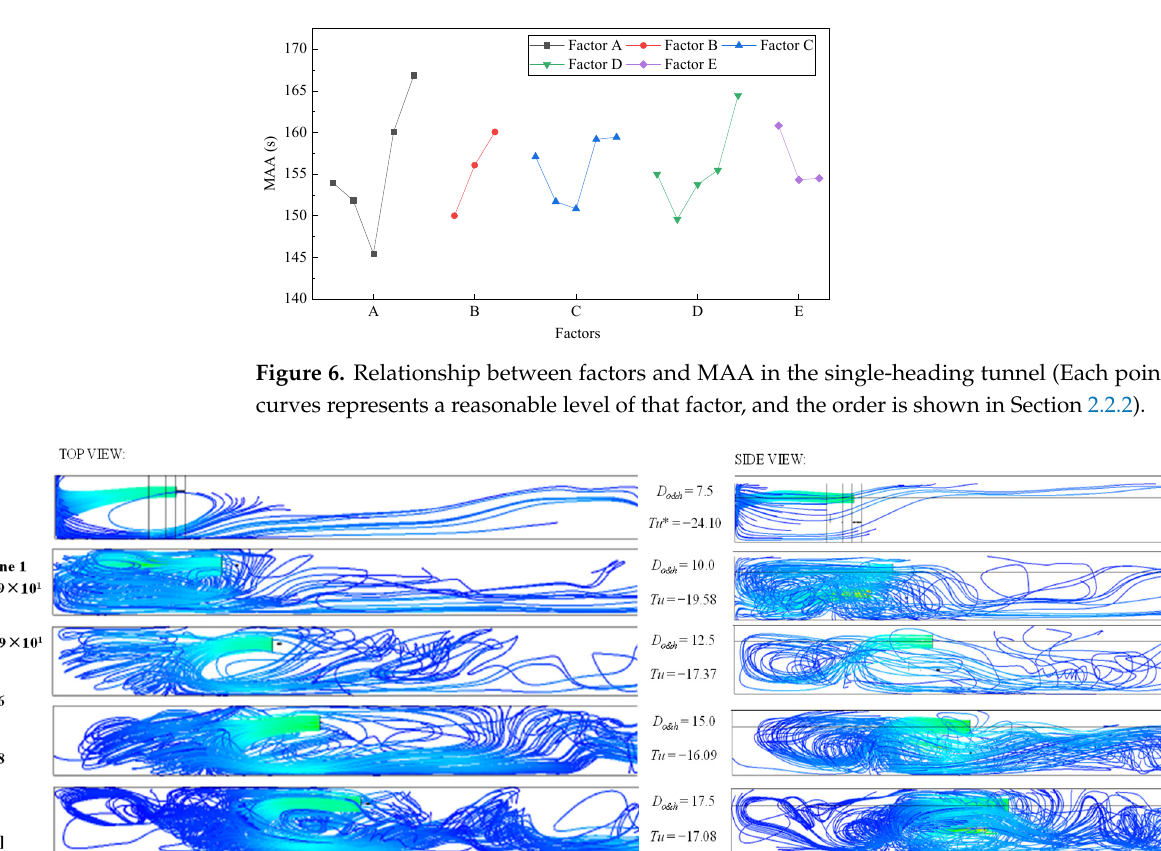
Figure 6. Relationship between factors and MAA in the single-heading tunnel.